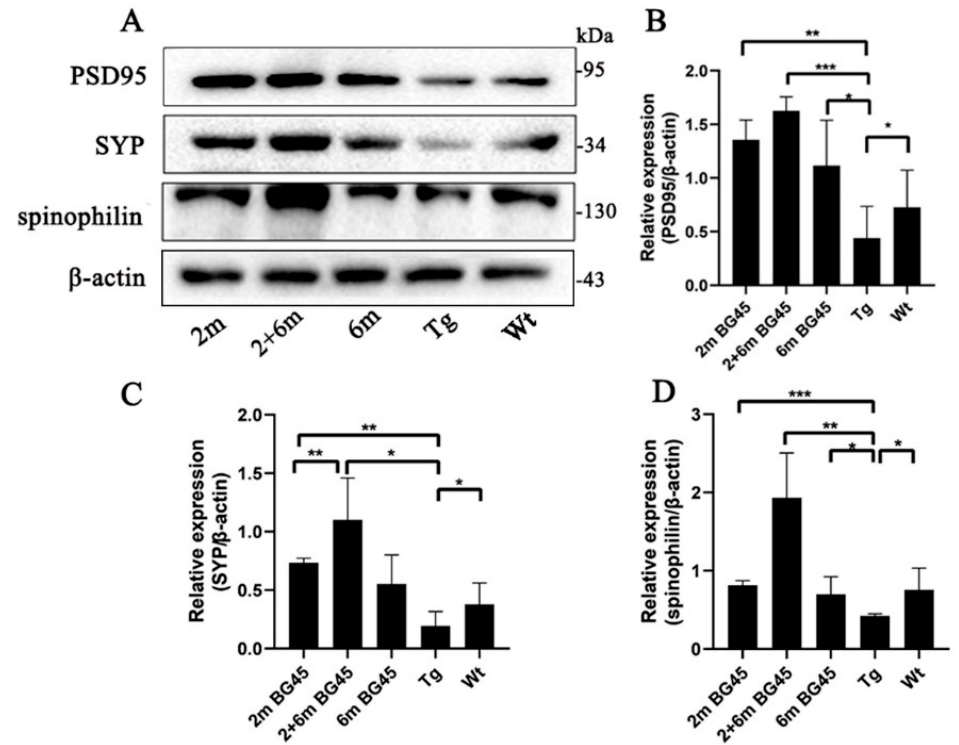
Figure 6. BG45 promoted the expression of synaptic proteins in the entorhinal cortexes of the APP/PS1 mice. ( A ) Representative protein expression bands of synaptic proteins. ( B – D ) Quantitative statistical analysis of the synaptic proteins. All values are presented as the means ± SDs from three independent experiments. *** p < 0.001, ** p < 0.01, and * p < 0.05. n = five mice per group.